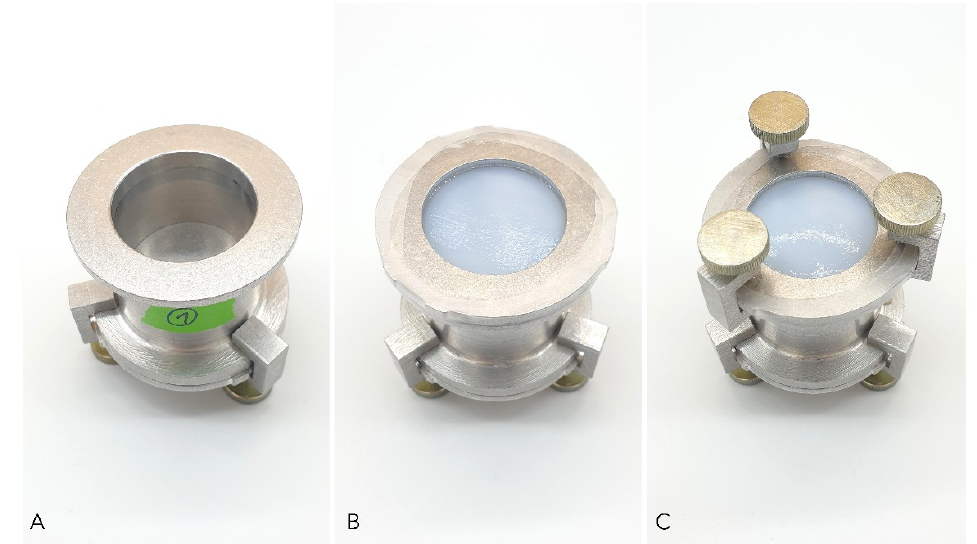
Figure 7. Standard Paddington cup method used to determine moisture vapor transmission rate (MVTR) of different wound dressings. ( A ) Paddington cup with defined orifice of 10 cm² filled with deionized water; ( B ) Dressing sample placed over the orifice secured with clamping plate and sealed with impermeable film to prevent evaporation through the edges; ( C ) Final setup for measuring MVTR; fixation of the setup with screw clamps.